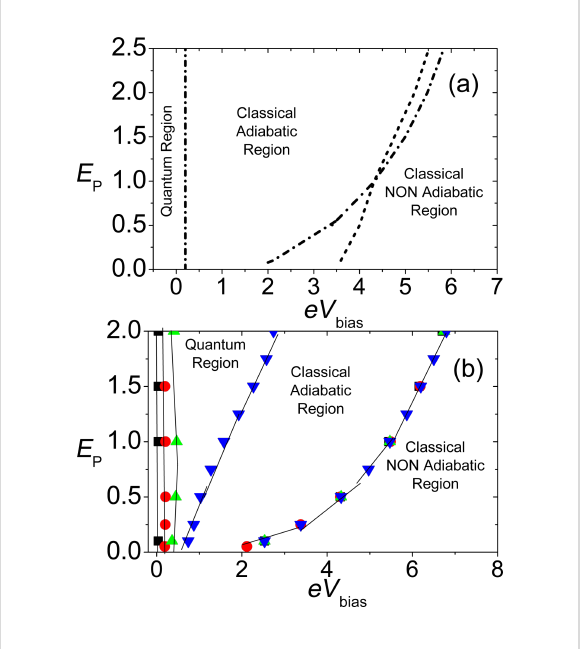
Figure 4: Phase diagrams expressing the validity of the adiabatic approximation. Panel (a): Phase diagram at fixed adiabatic ratio ω 0 / Γ = 0.05. The dashed (black) line indicates the QR–CAR crossover for V G = 0 and V G = 1. The dotted and dashed dotted lines indicate the CAR–CNAR crossover for V G = 0 and V G = 1, respectively. Panel (b): Phase diagram at fixed gate voltage V G = 0 (asymmetric static poten- tial) for different adiabatic ratios ω 0 / Γ = 0.01, 0.05, 0.1 and 0.25. Adapted from